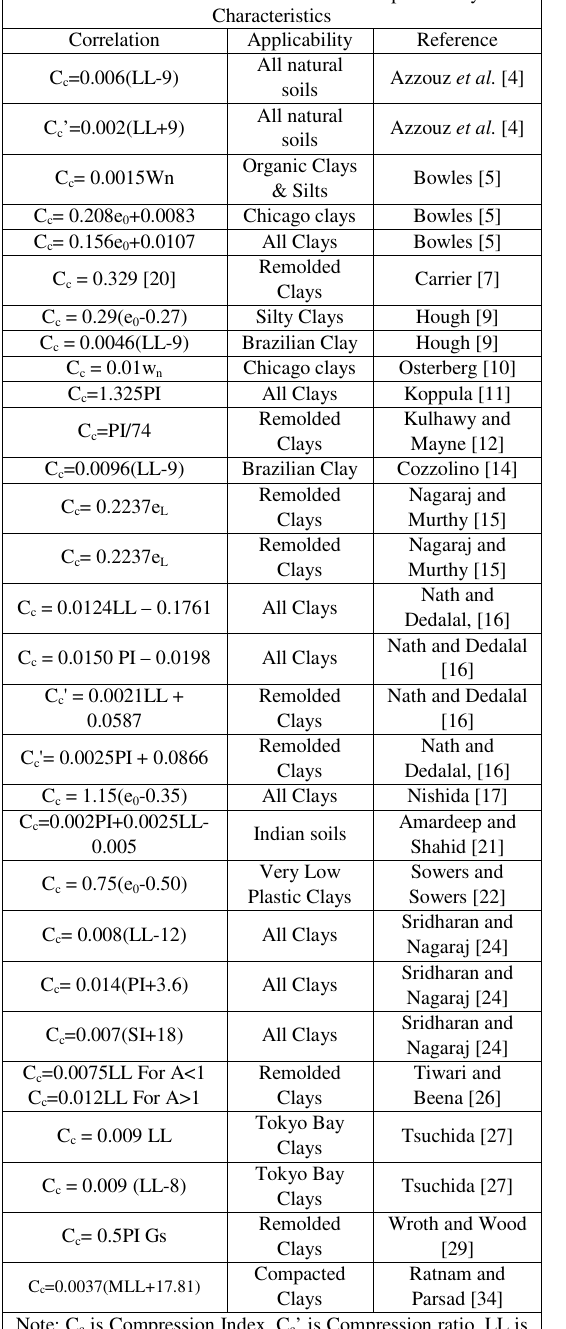
Table 1: Predictive Correlations for Compressibility Characteristics